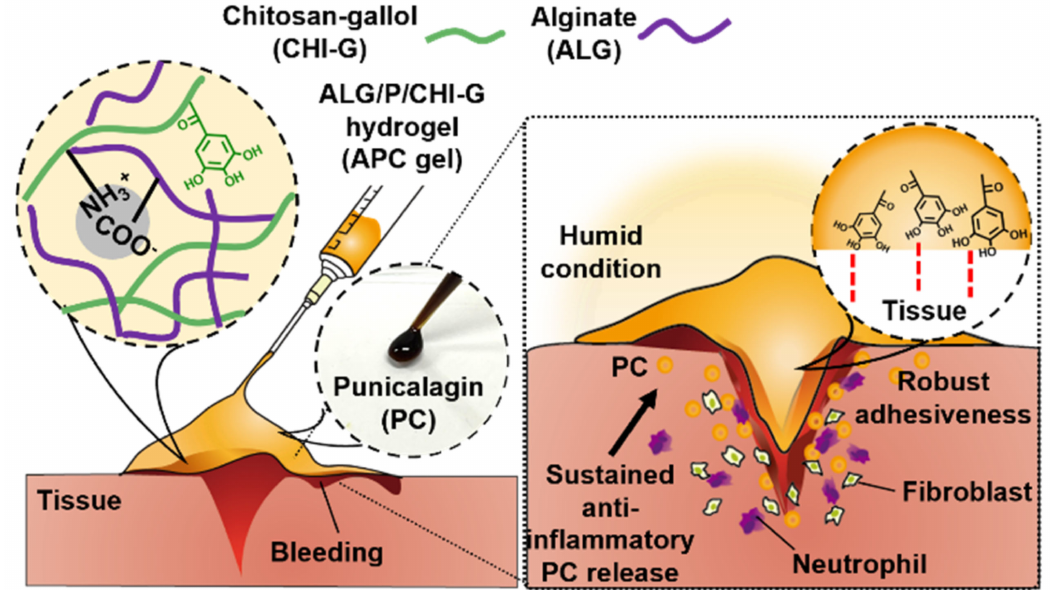
Figure 1. Schematics of the ALG/PC/CHI–G (APC) hydrogel ( left ) with robust tissue-adhesiveness and sustained release of therapeutic PC ( right ) for effective wound